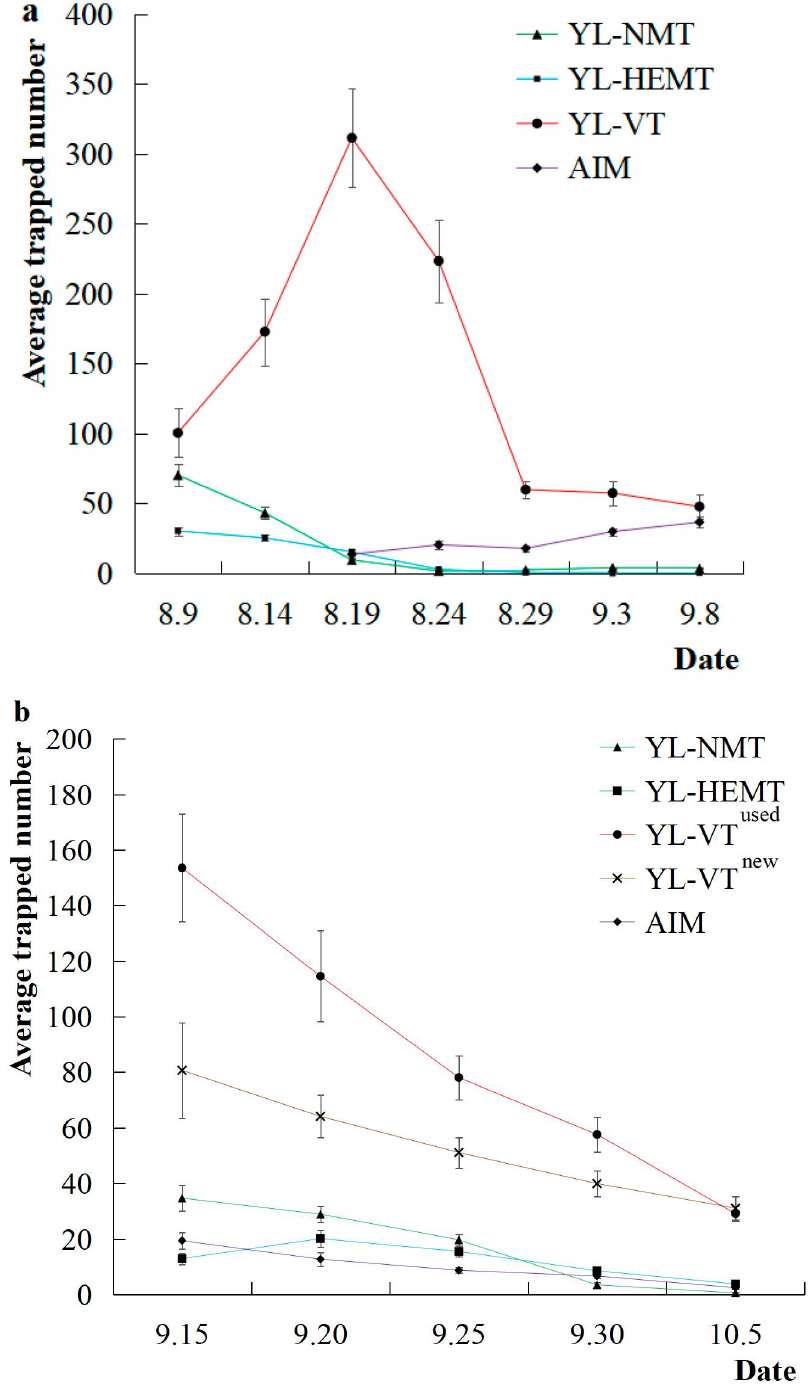
Figure 4. Trapping dynamics of S. litura with three conventional traps and AIM in 2020. ( a ) Average trapping dynamics of S. litura for each trap every 5 days, from 5 August to 8 September; ( b ) Average trapping dynamics of S. litura for each trap every 5 days, from 11 September to 5 October. Traps YL-VT used are YL-VT traps that had been used from 5 August to 8 September, and a new lure core was replaced, with subsequent reuse in the trapping experiment from 11 September to 5 October. Traps YL-VT new are new YL-VT traps equipped with new pheromone lure cores. All data are mean ±